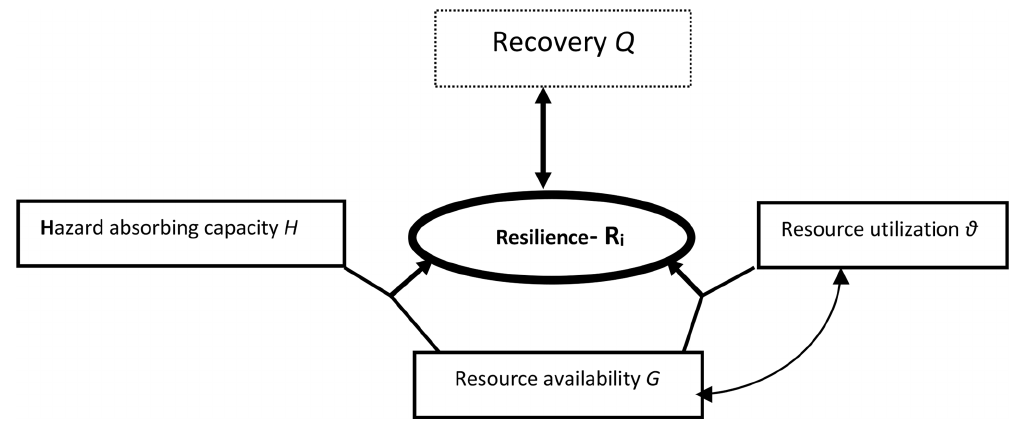
Figure 1. Resilience measuring conceptual framework.